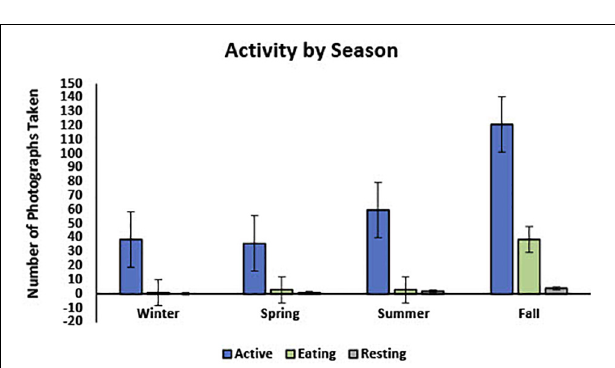
FIGURE 5 | Shows the proportion of photos taken during each season separated into three activity categories, “Active,” “Eating (Foraging),” and